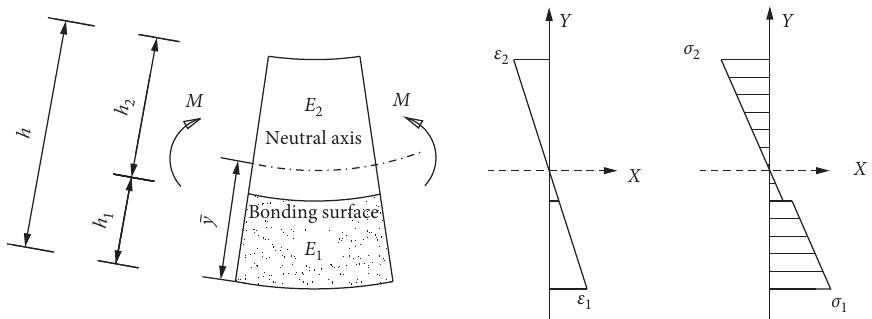
Figure 18: Calculation segment diagram among the pure bending zone.